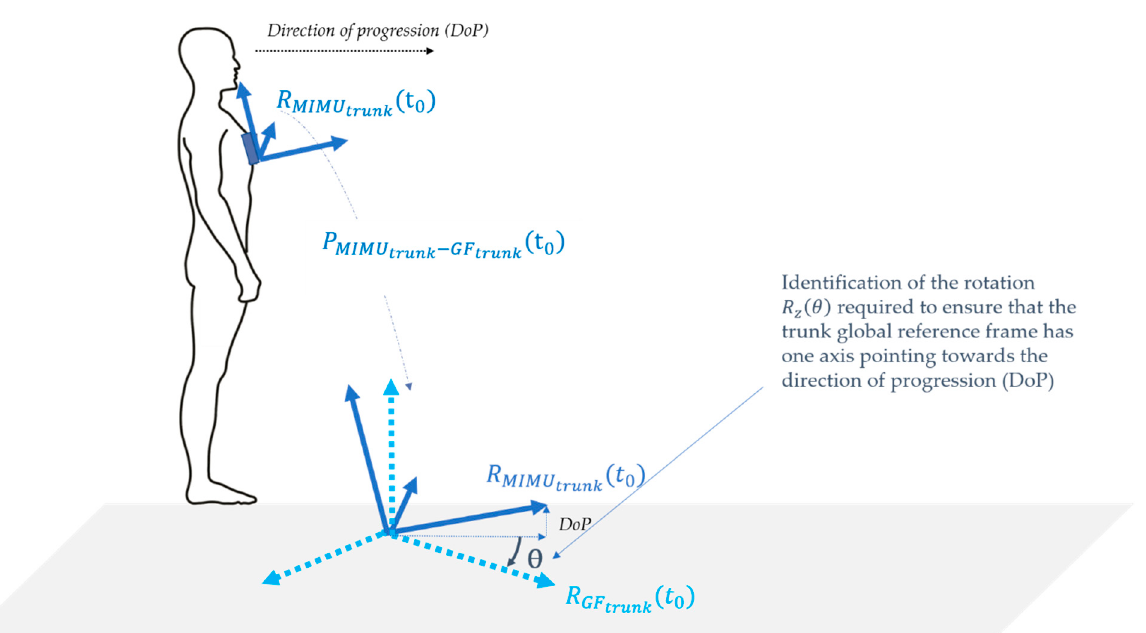
Figure 2. Rotation (cid:1844) (cid:3053) ((cid:2016)) of the trunk-MIMU-sensed Earth-fixed frame ( (cid:1844) (cid:3008)(cid:3007) Figure 2. Rotation R z ( θ ) of the trunk-MIMU-sensed Earth-fixed frame ( R GF tion of progression, using the orientation of the trunk MIMU local frame ( (cid:1844) (cid:3014)(cid:3010)(cid:3014)(cid:3022) progression, using the orientation of the trunk MIMU local frame ( R MIMU